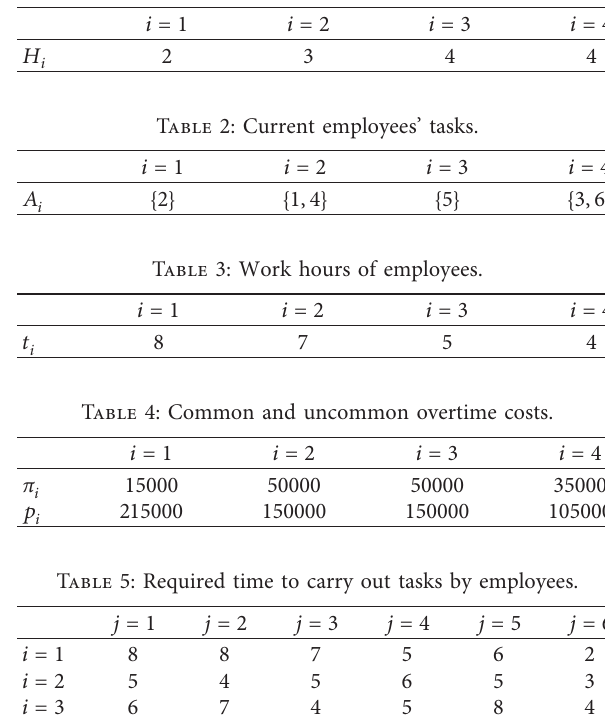
Table 1: Maximum overtime.